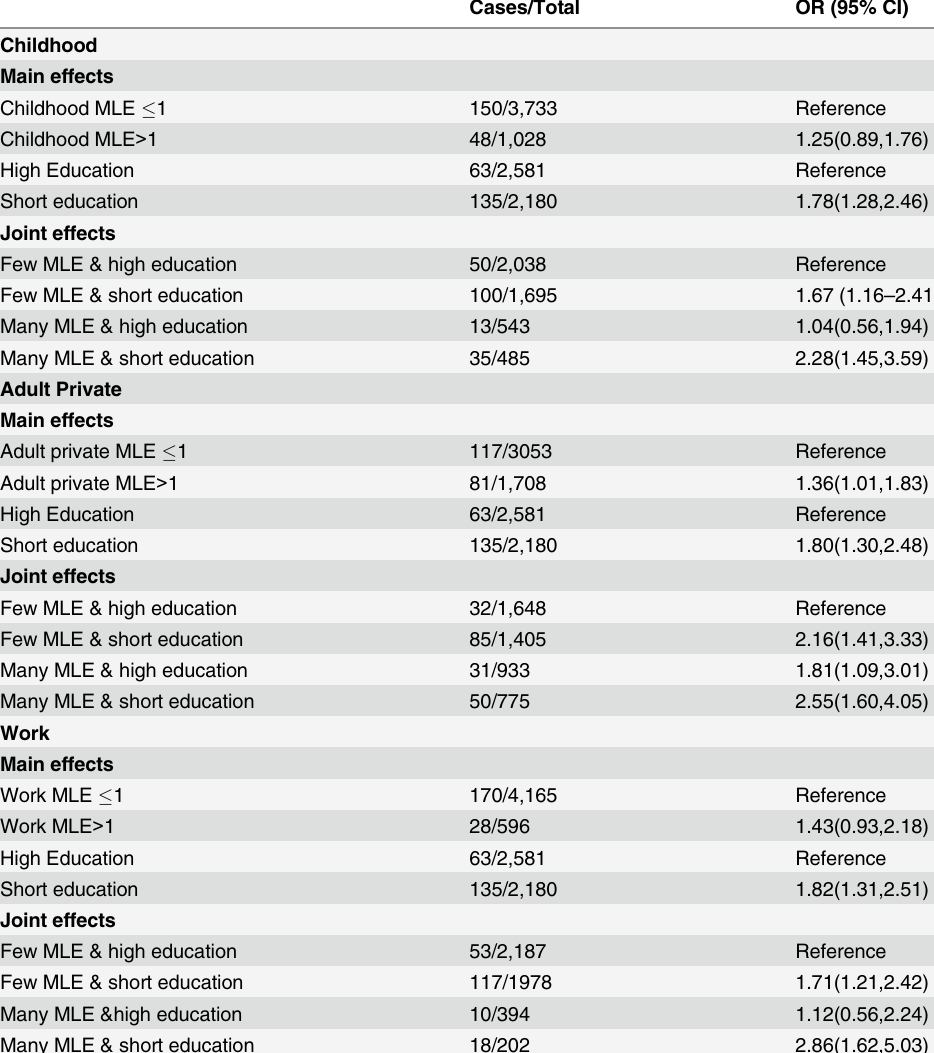
Table 4. Odds ratios(OR) and ± 95% confidence interval (CI) for the joint association of major life events (MLE) in childhood, adult private life and work life and education on risk of type 2 diabetes mel- litus (N = 4,693). Odds ratios adjusted for sex, age, family history of diabetes. The main effects of education are additionally for MLE in childhood, adult private or work life and the main effects of MLE are additionally adjusted for education. Cases/Total OR (95%